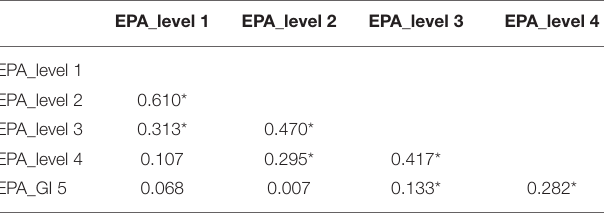
TABLE 10 | Association Co-efficients general EPAs-GI EPA 5 for